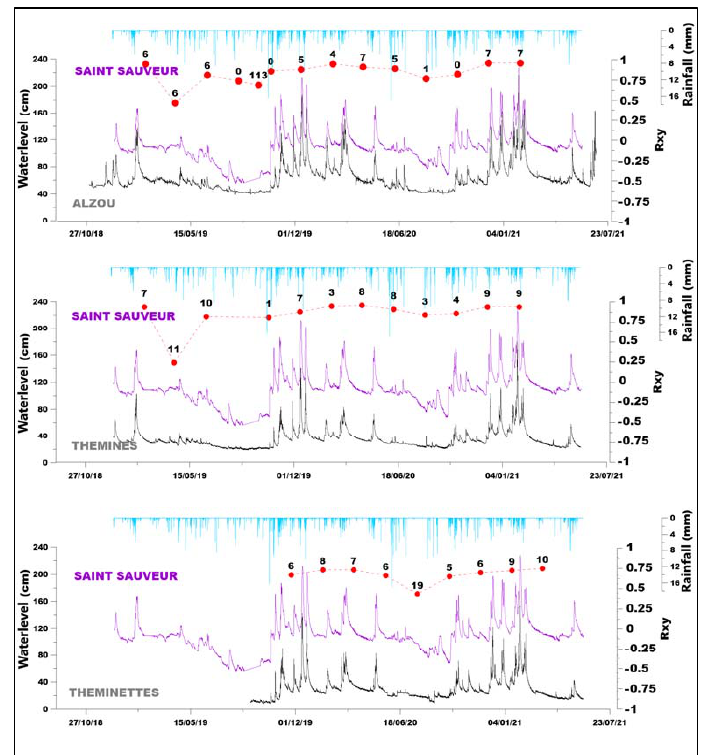
Figure A3. Sliding correlation analyses between the water level for the Saint Sauveur station and the different stations at the sinks; the results of the sliding cross-correlation analyses are displayed in red dots (vertical axis: correlation, label: time lag between the two sites in hours).